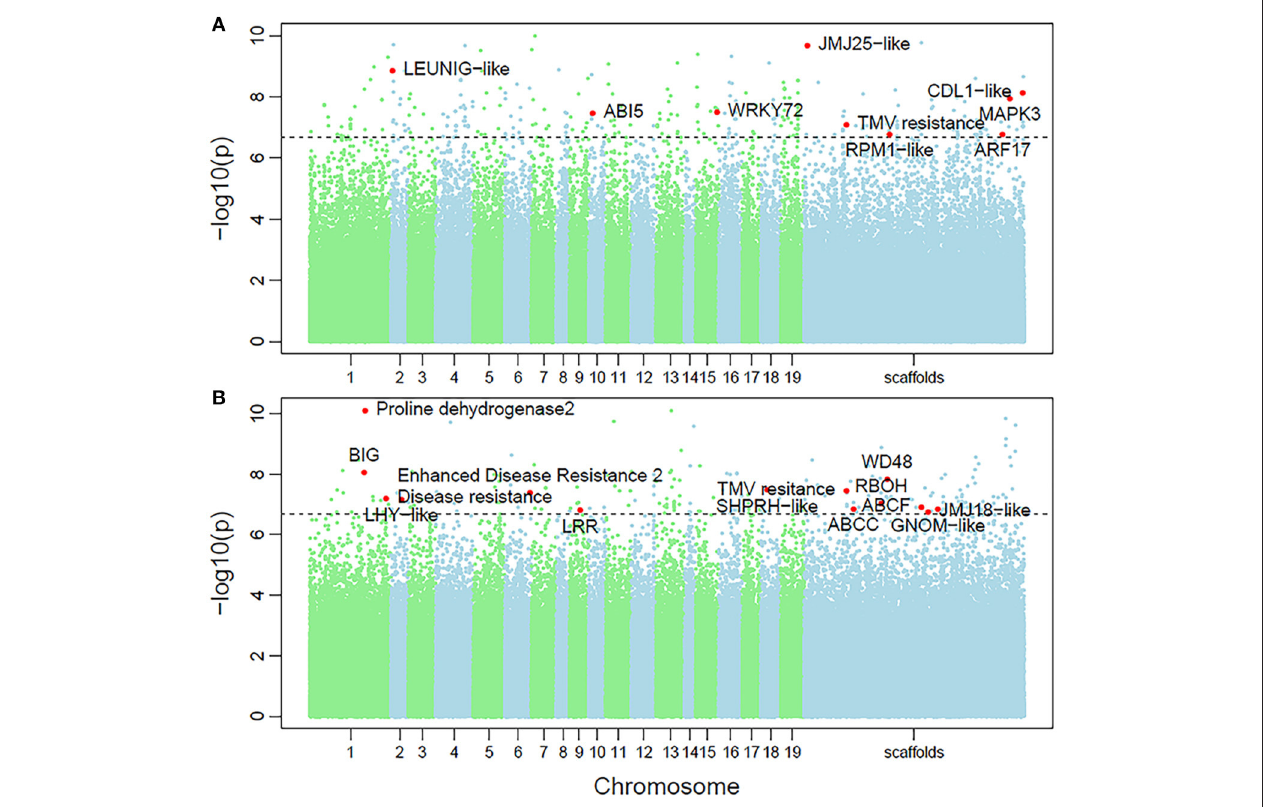
FIGURE 6 | Manhattan plots of genome-wide association of heterophylly trait results for the (A) control and (B) salt stress groups. Dotted line indicates the 5% significance threshold.